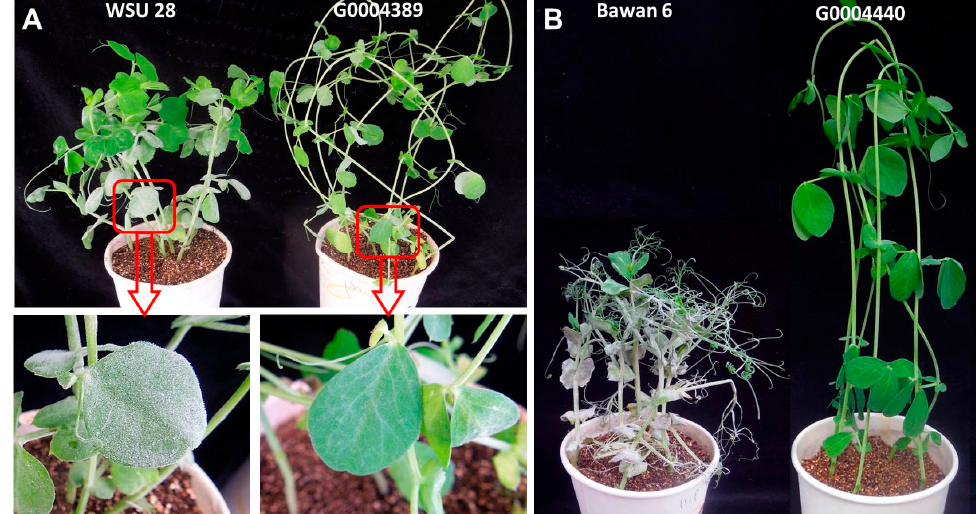
Figure 2. Phenotypic evaluation of the Erysiphe pisi -resistant pea germplasms G0004389 and G0004400, as well as the E. pisi- susceptible cultivars WSU 28 and Bawan 6, after inoculation with E. pisi isolate EPYN. ( A ) G0004389 and E. pisi- susceptible cultivar WSU 28. ( B ) G0004400 and